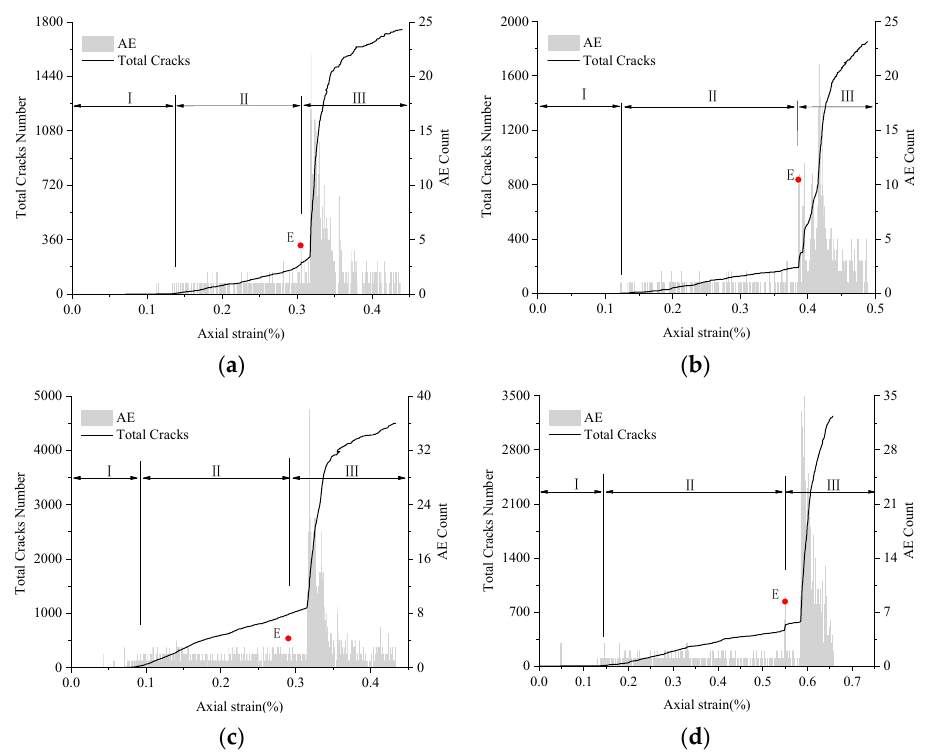
Figure 7. Total cracks and AE curves of various rock specimens. ( a ) LdB granite, ( b ) Augig granite, ( c ) TS, and ( d ) coal. Note: Red point E represents the information recognition point of the rock failure precursor.